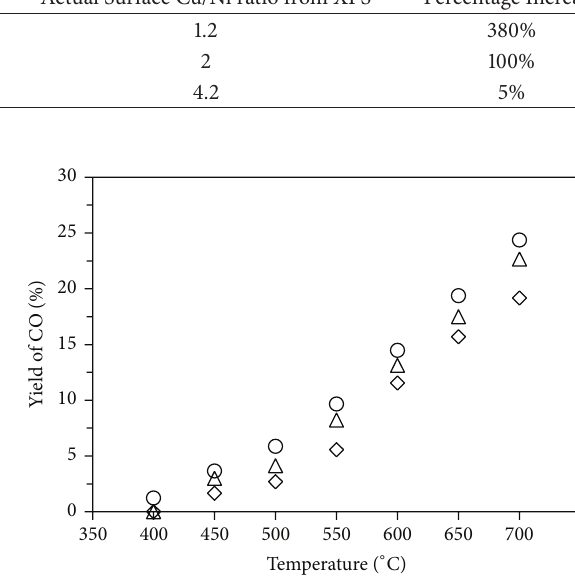
Figure 3: RWGS reaction at 1atm, 𝑃 He, GHSV = 176000 h −1 , and 50 mg of catalyst: Cu 80 Ni 20 /C, 10wt%, where ⃝ = 1st cycle, △ = 2nd cycle, and ⬦ = 3rd cycle.